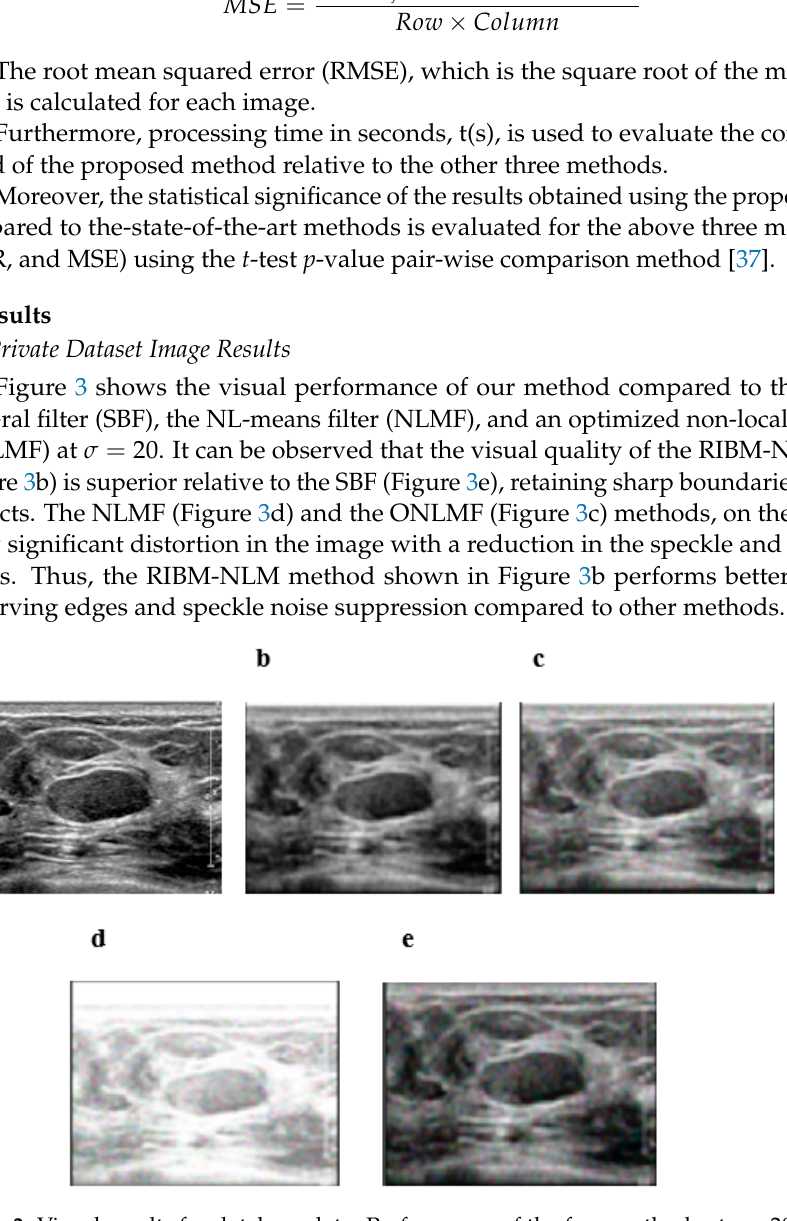
Table 1. SSIM values for several algorithms using database images. NLMF, non-local means filter; ONLMF, optimized non-local means filter; SBF, switching bilateral filter; SSIM, self-similarity index metrics; σ , Gaussian blur standard deviation.